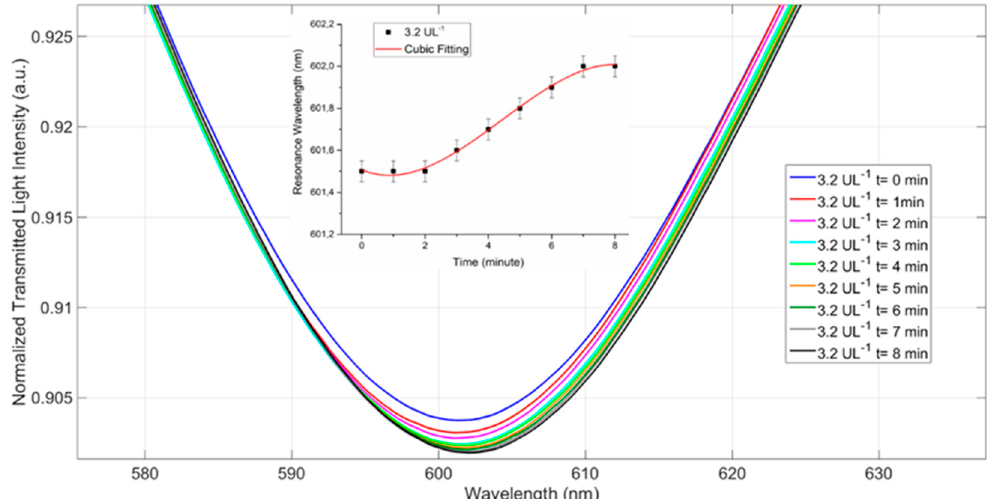
Figure 6. Kinetics of binding of 3.2 U/L amylase in surgically-placed drain effluent solution to the POF-biosensor. During the sample incubation ( t = 8 min) the optical minimum shifts were recorded and plotted over time (inset). Eight minutes showed the endpoint of the kinetics and was chosen as the incubation time for all the measurements. The error bars were calculated on a same POF-biosensor platform and equal to 0.2 nm.